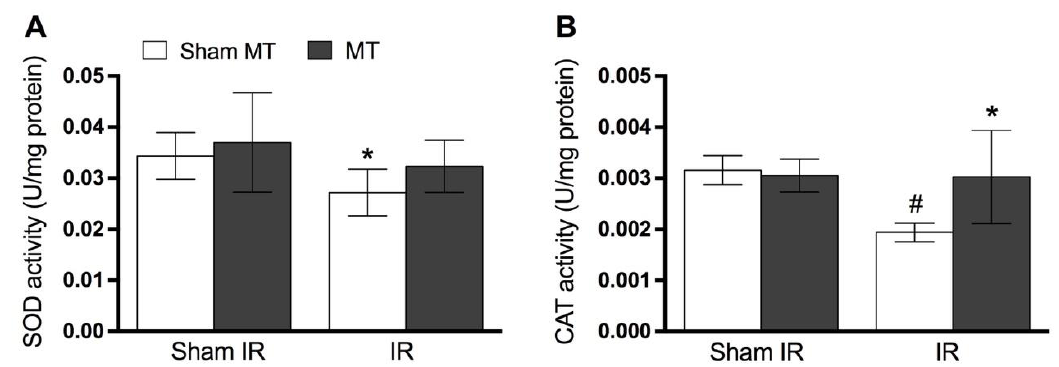
Figure 4. Evidence of MT effects on anti-oxidant enzymes levels at the 2nd day after IR procedure. Panel A shows that there was no significant difference on superoxide dismutase (SOD) activity, while panel B shows a significant difference on CAT activity. Each point represents the mean of 8 animals and vertical lines show the SD. Statistical analyses were performed by one-way ANOVA followed by Newman–Keuls Multiple Comparison Test. The symbols denote a significant difference of * p < 0.05 when compared to IR + Sham MT group, # p < 0.05 when compared to Sham + Sham MT group. MT: Manual therapy, IR: Ischemia and reperfusion, SOD: Superoxide dismutase, CAT: Catalase.